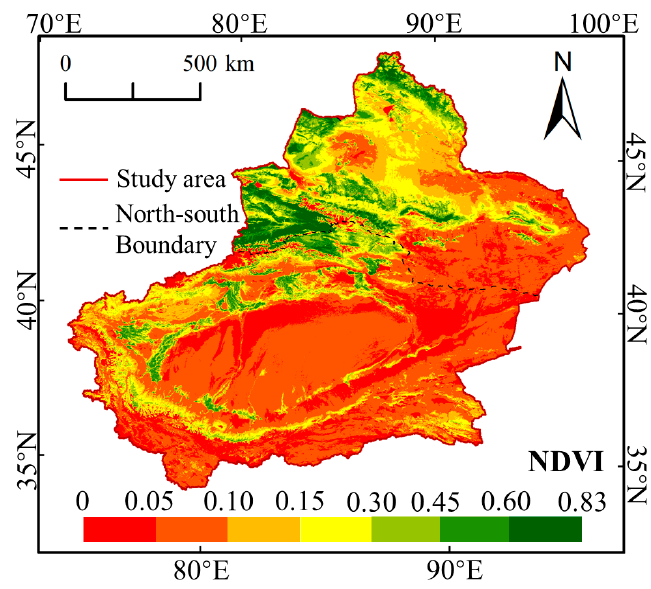
Figure 6. Yearly average NDVI for growing season in Xinjiang during 2000–2018.